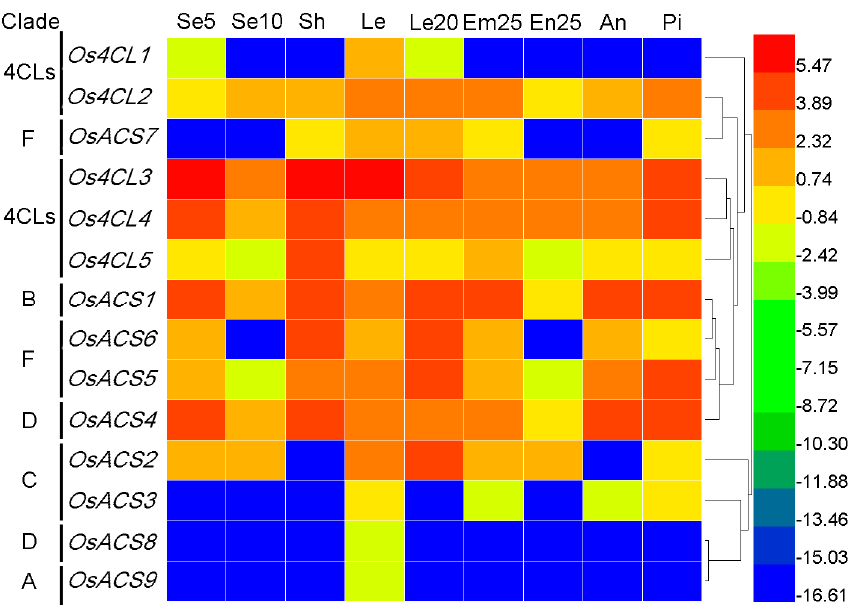
Figure 8. Expression patterns of ACS/4CL genes in rice in different organs. Se5, seeds at 5 DAP; Se10, seeds at 10 DAP; Sh, shoots; Le20, leaves at 20 days; Le, seedlings at the four-leaf stage; Em25, embryos at 25 DAP; En25, endosperm at 25 DAP; An, anthers; and Pi, pistils. Clades are defined in Figure 1.